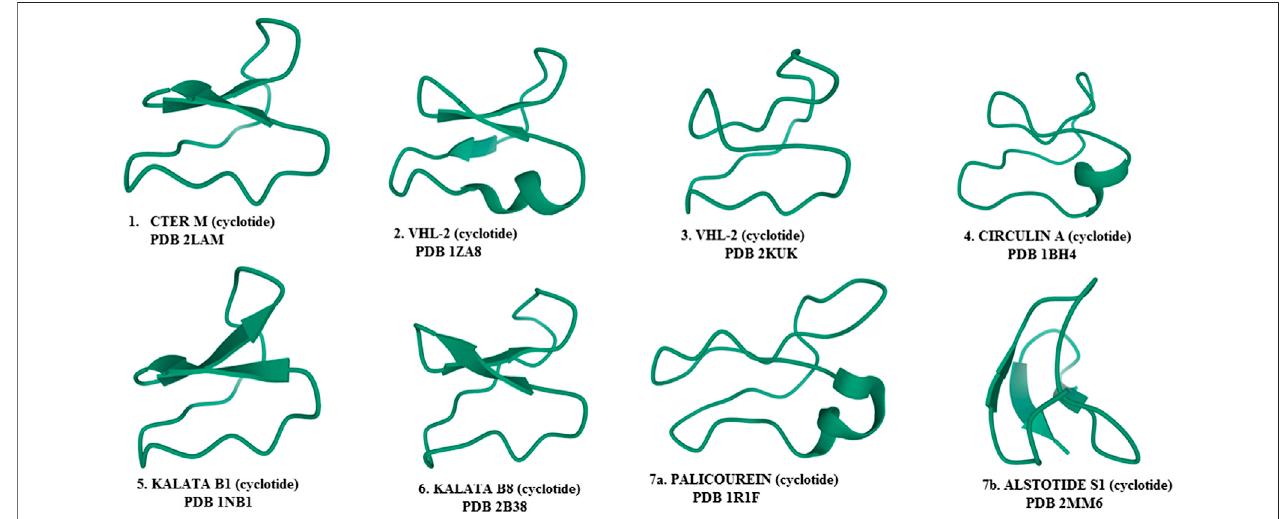
FIGURE 5 | Antiviral cyclotides (cysteine-rich peptides) isolated from